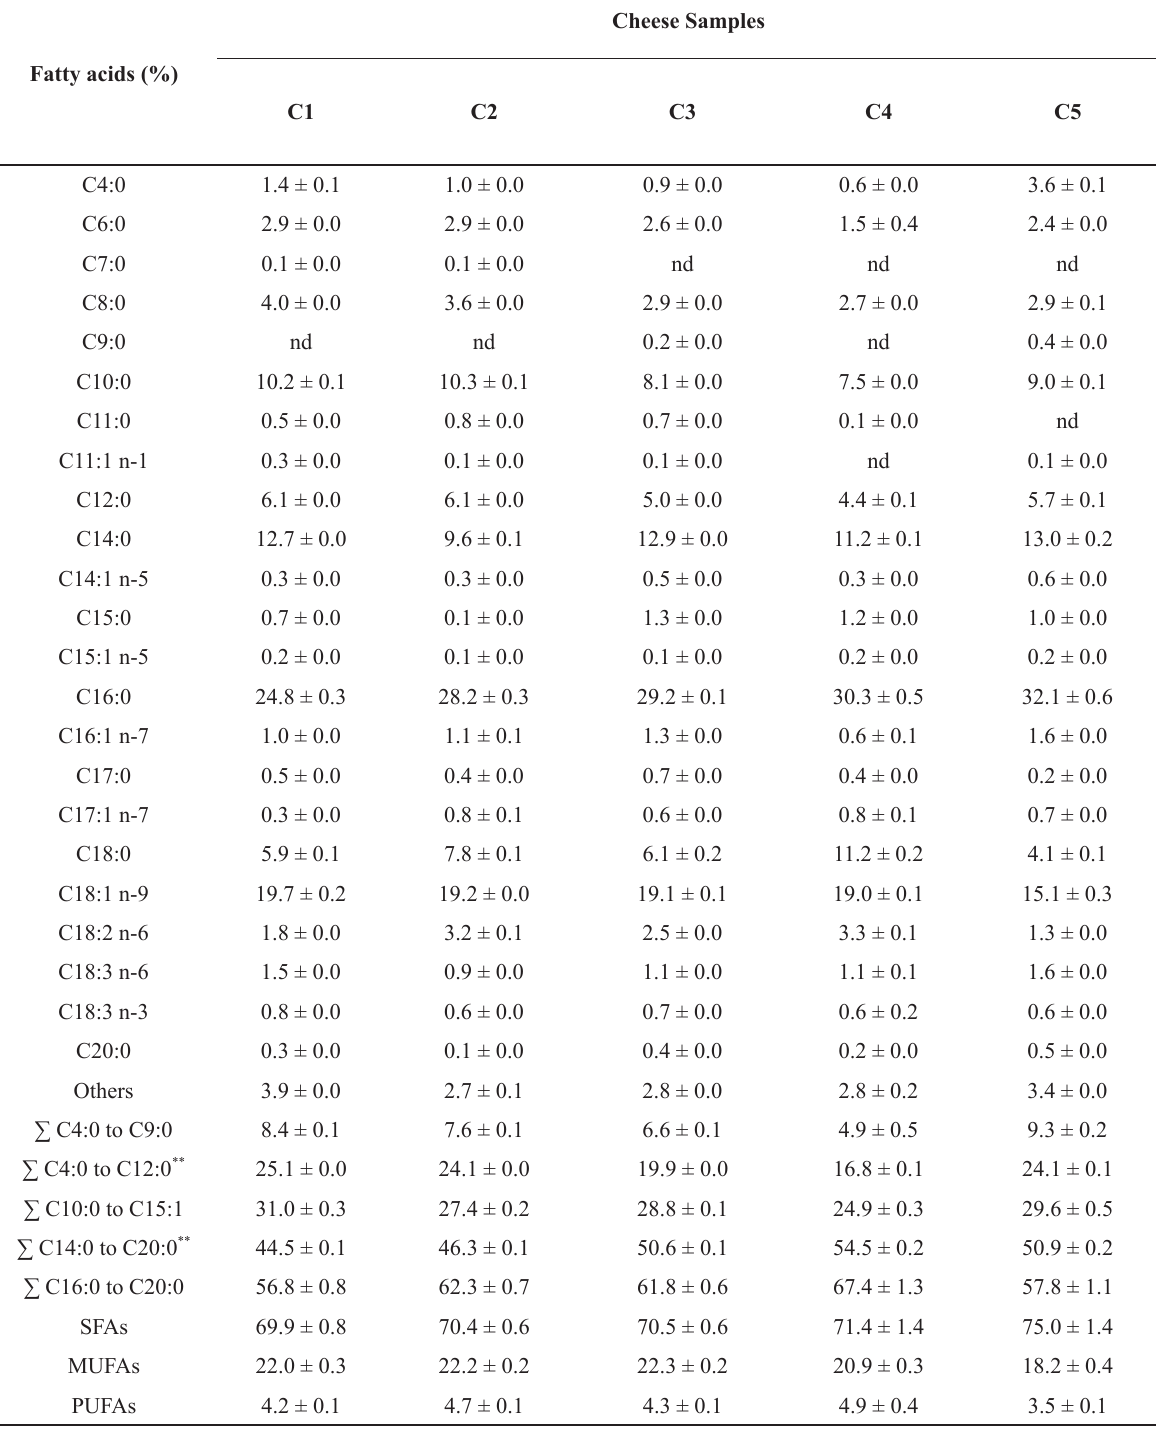
nd: non determined, SFAs: Saturated fatty acids, MUFAs: Monounsaturated fatty acids, PUFAs: Polyunsaturated fatty acids, ** : Sum of saturated fatty